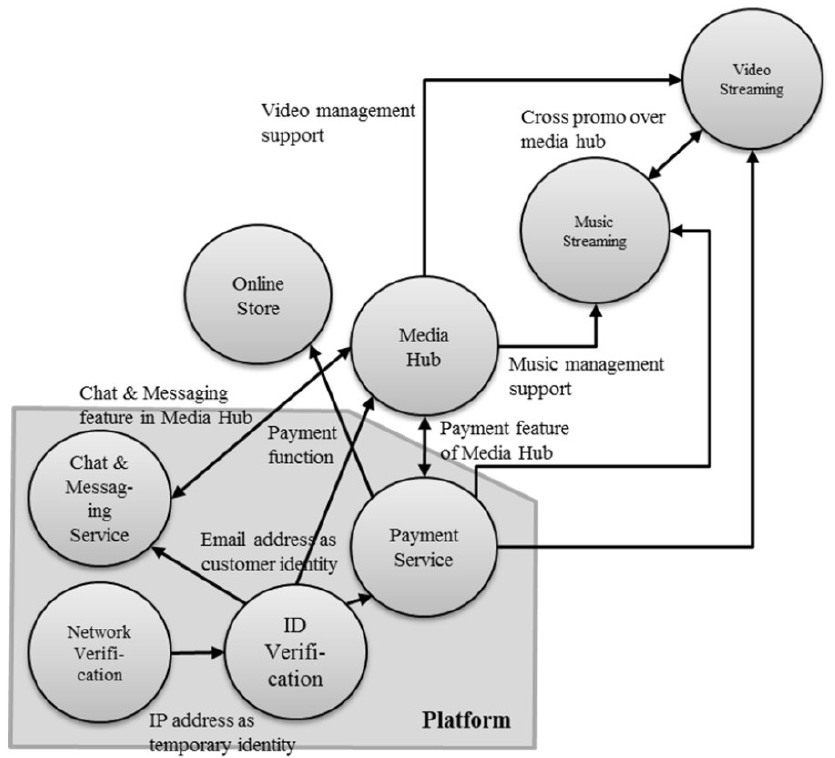
Figure 3. An Example of OTT Initiative Portfolio using Dependency Relationship